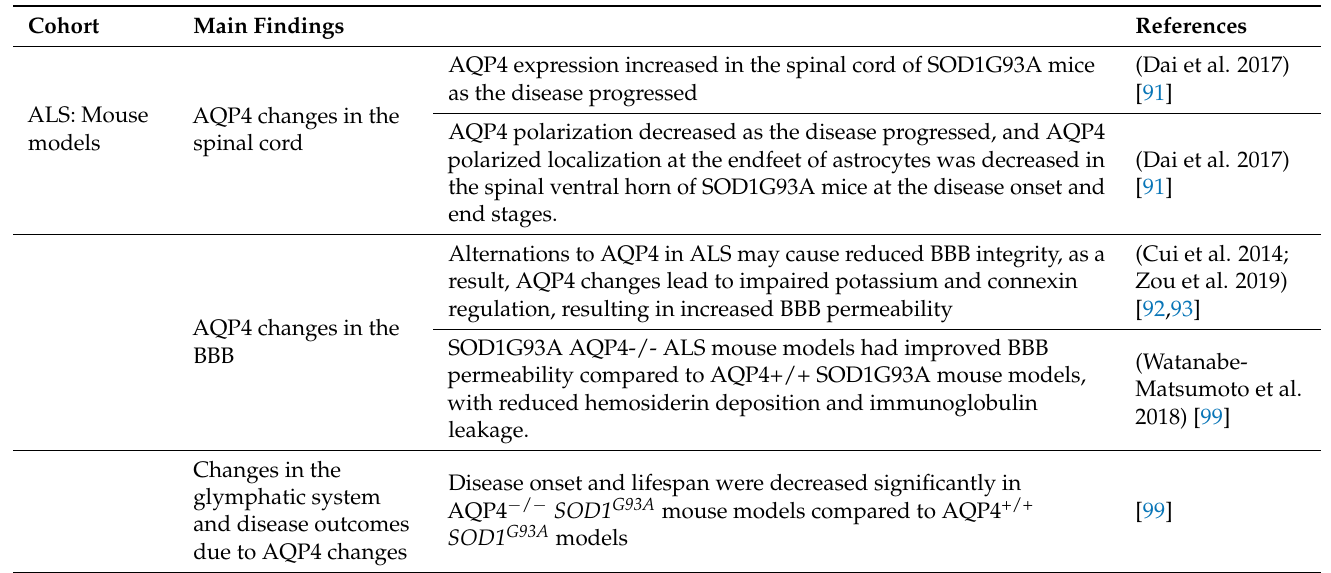
Table 3. Summary of the main findings from studies exploring glymphatic changes in Amyotrophic Lateral